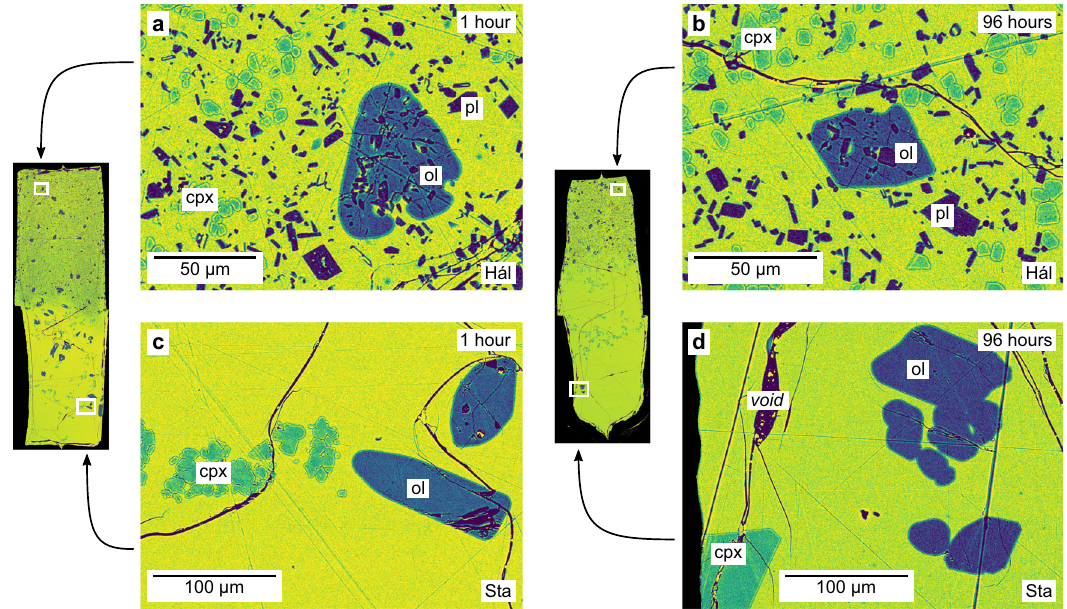
Fig. 4 False-colour backscattered electron (BSE) images of the products of 1- and 96-h magma – magma reaction experiments. a , b Neither the far- fi eld texture nor abundance of crystals change appreciably in portions of the experimental products derived from the Háleyjabunga (Hál) lava analogue far from original magma – magma interfaces as experimental duration increases from 1 h ( a ) to 96 h ( b ). There is no clear evidence of Ostwald ripening in these portions of our experimental products. c , d Although the far- fi eld abundance of crystals appears to decrease in portions of experimental products derived from the Stapafell (Sta) lava analogue far from original magma – magma interfaces as experimental duration increases from 1 h ( c ) to 96 h ( d ), crystal textures remain mostly the same. Speci fi cally, while olivine crystals have similar sizes and textures after 1 and 96 h, clinopyroxene crystals may have decreased in number and increased in size by Ostwald ripening (i.e. coarsening). Phases are labelled as follows: gl glass (green to yellow), cpx clinopyroxene (blue-green), ol olivine (blue), pl plagioclase